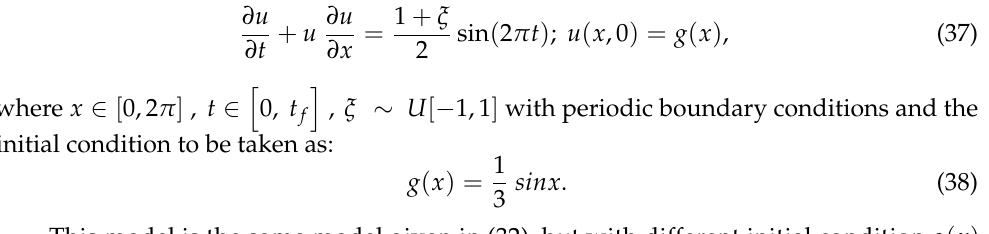
Figure 15. The mean solution field   (  ,  ) ( left ) and its contour lines ( right ) for the inviscid Burgers’ equation using the DO method.